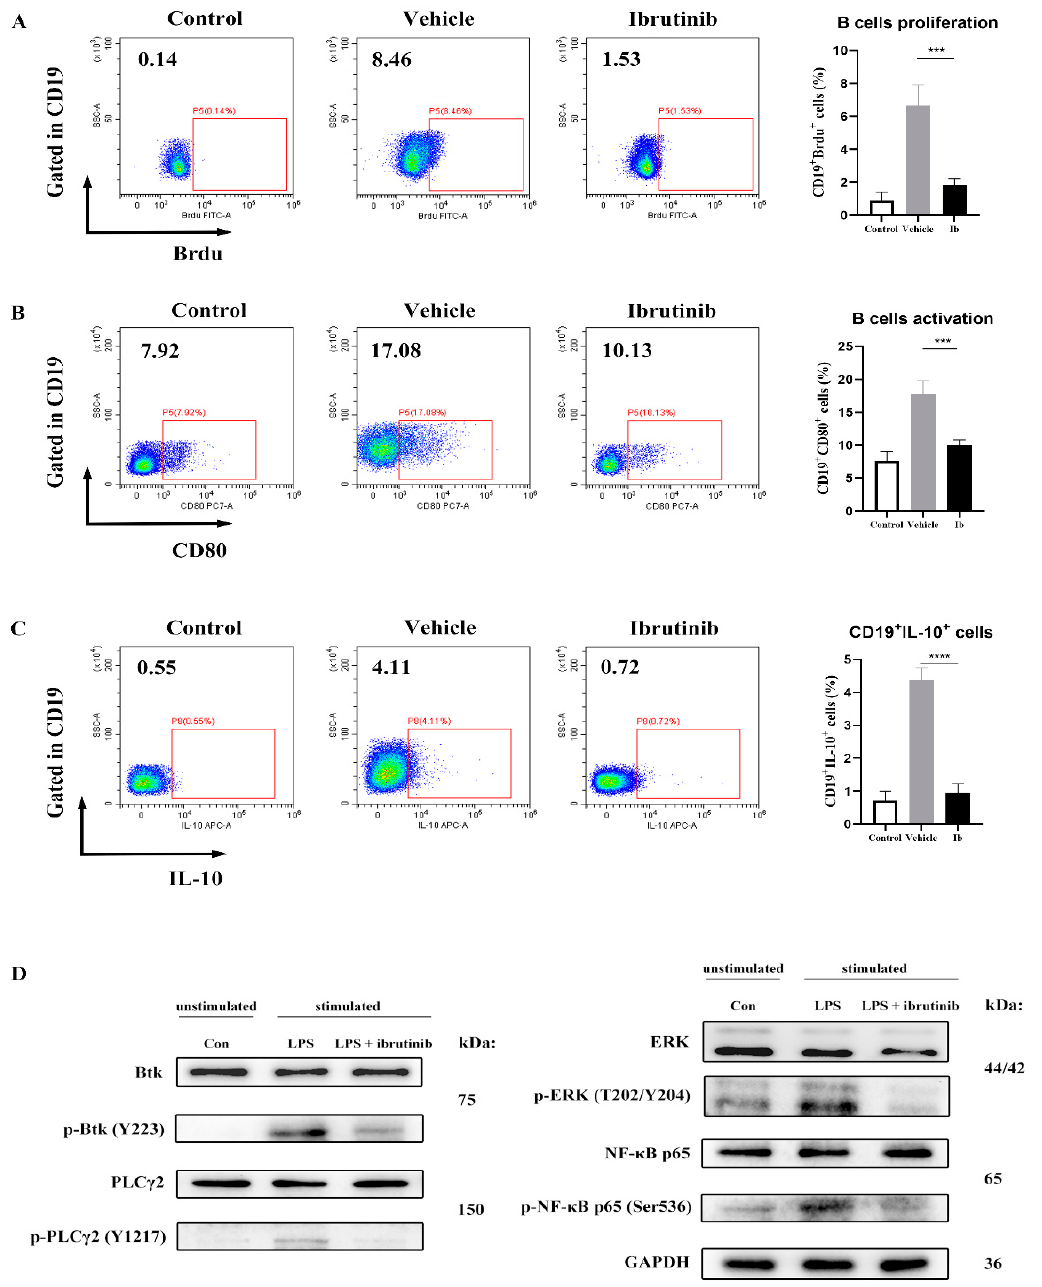
Figure 2. In vitro B cell activation and proliferation are suppressed by a low dose of ibrutinib through inhibiting BTK signaling. Mouse splenic B cells were purified and isolated using antimouse CD19 magnetic microbeads and the AutoMACS program. Purified B cells were stimulated with 10 µ g/mL LPS and treated with 1 µ M ibrutinib or DMSO for 72 h. ( A – C ) B cell proliferation, activation, and IL-10 production were determined by flow cytometry. ( D ). Western blot assays were performed to analyze the protein levels of the BTK signaling pathway in B cells. A p value less than 0.05 was considered statistically significant. ***, p < 0.001; ****, p < 0.0001. The uncropped bolts are shown in Supplementary Materials File S1.